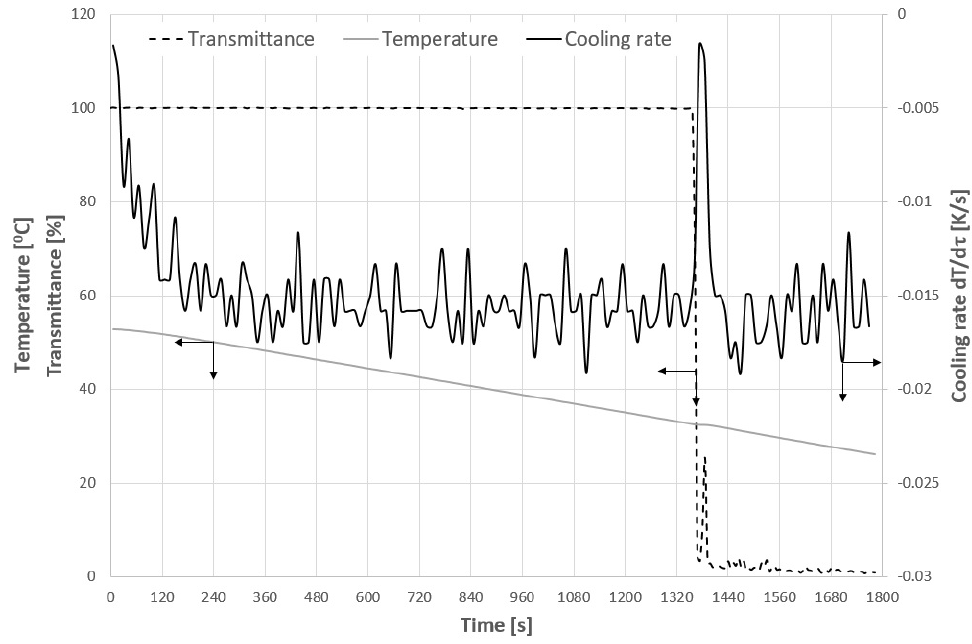
Figure 3. Exemplary measurement results for 29% w / w KCL solution.